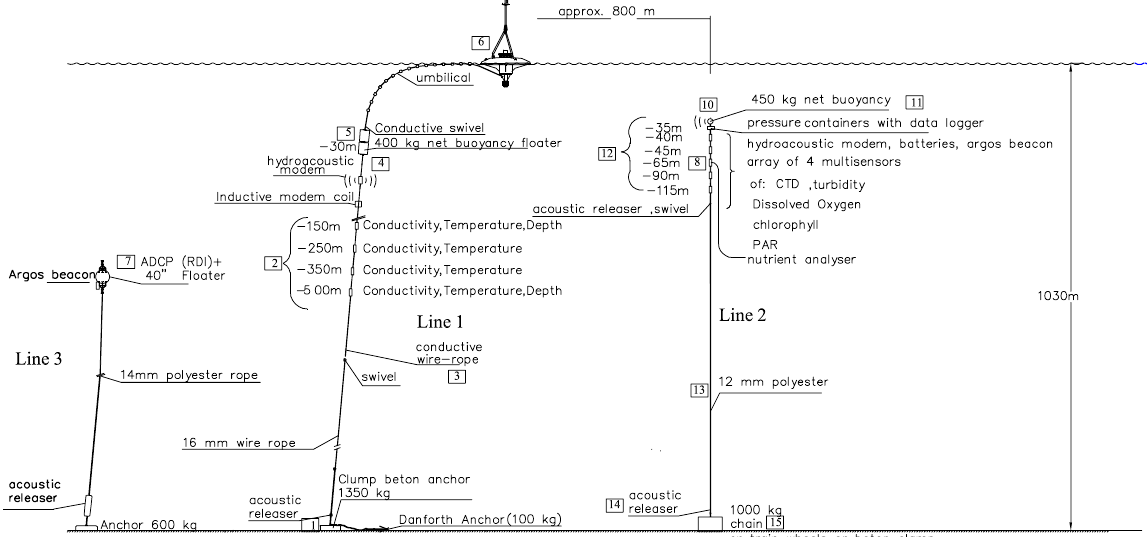
Fig. 1. Design of the M3A